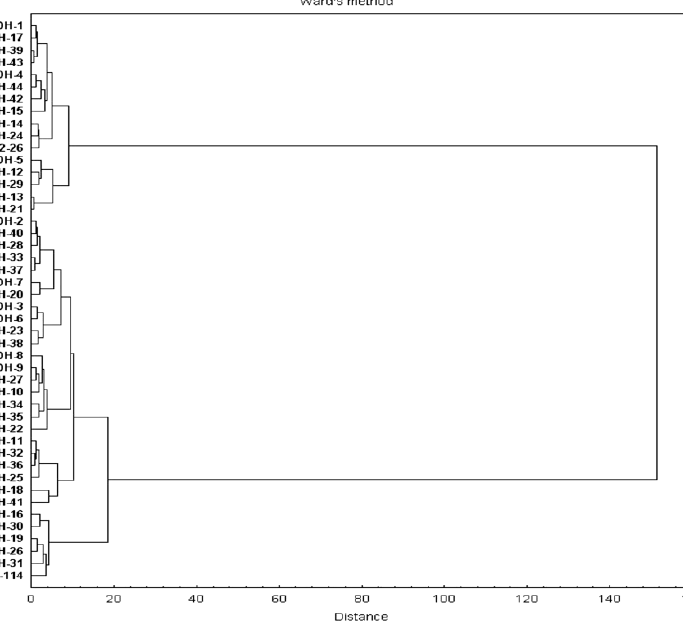
Figure 4. Clustering dendrogram obtained on the basis of six studied traits. Table 6. Estimates and testing results of contrasts between chosen DH lines with low fibre content and yellow-seeded parental DH line